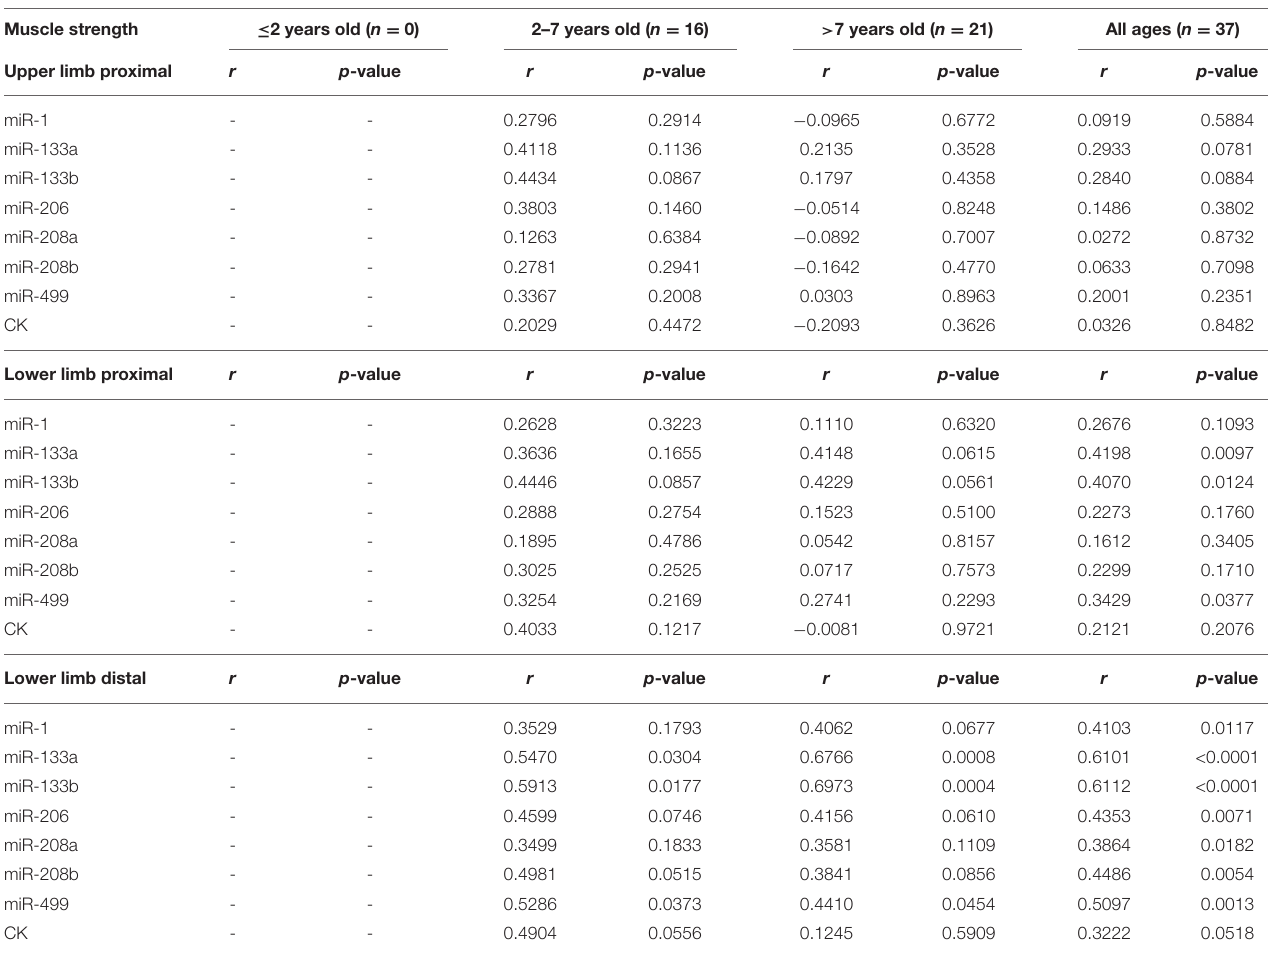
TABLE 5 | Correlation between serum myomiRs and CK levels and muscle strength. Muscle